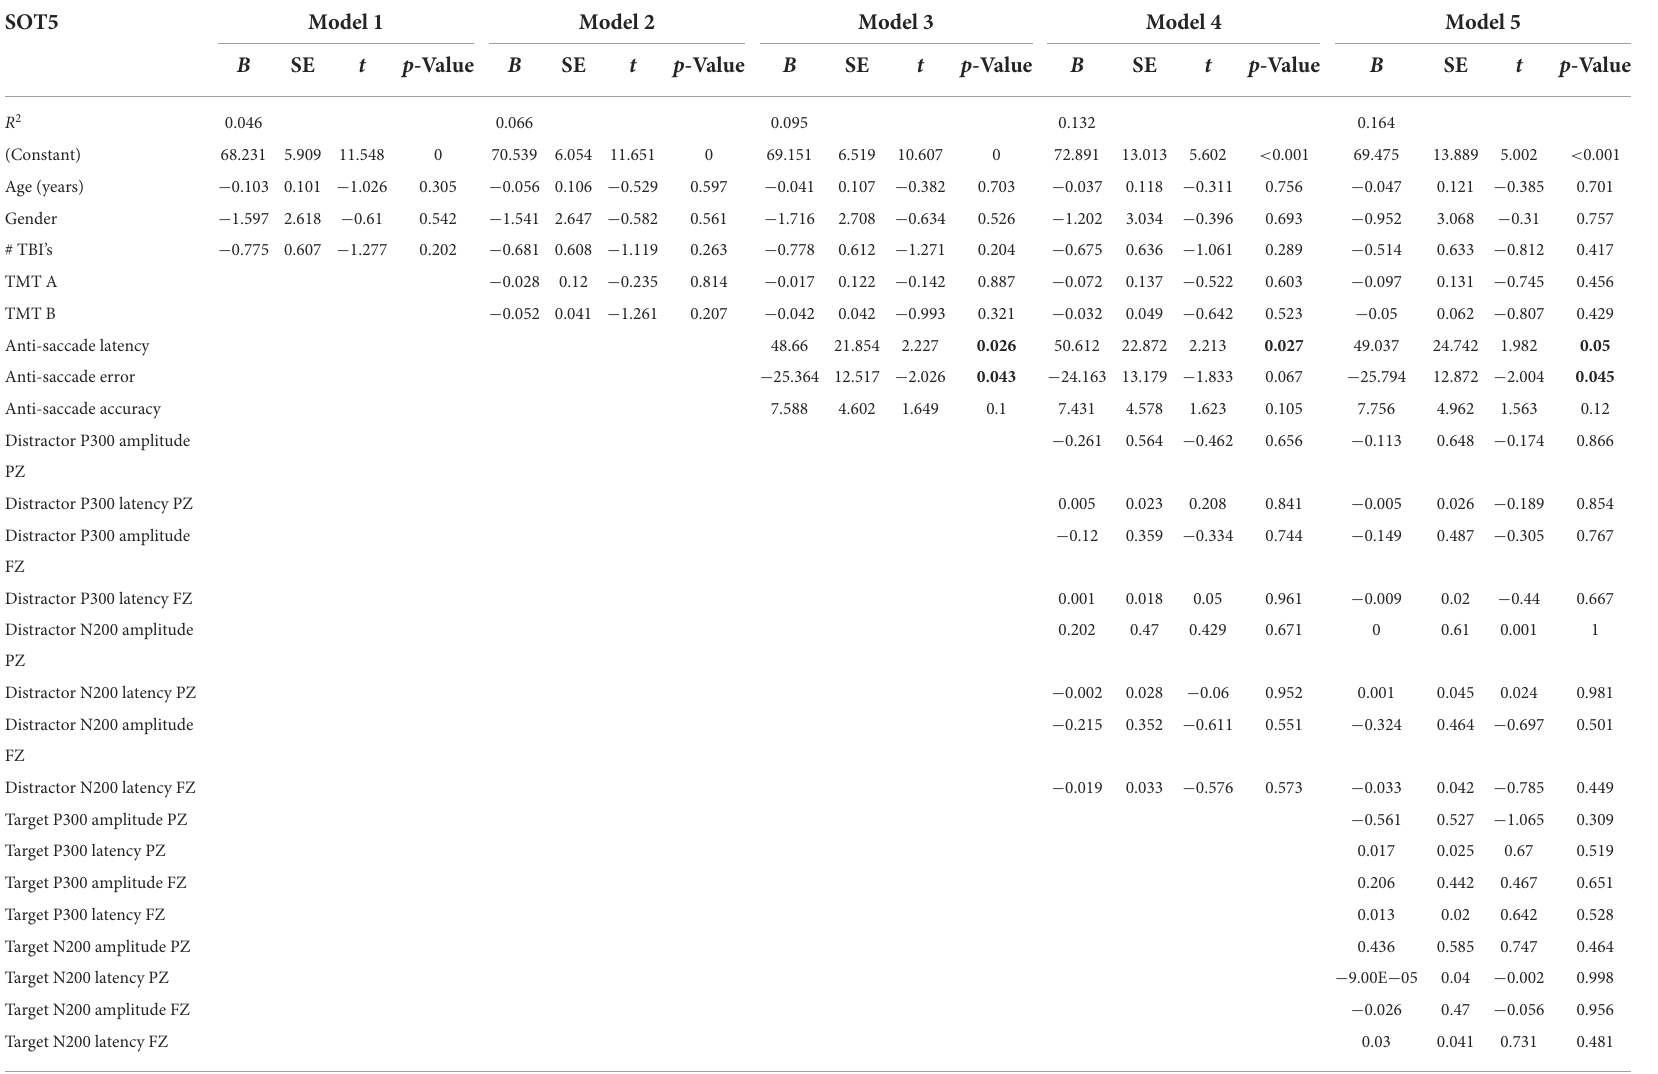
TABLE 6 Results from the hierarchical regression for SOT5, eyes closed with a sway-referenced